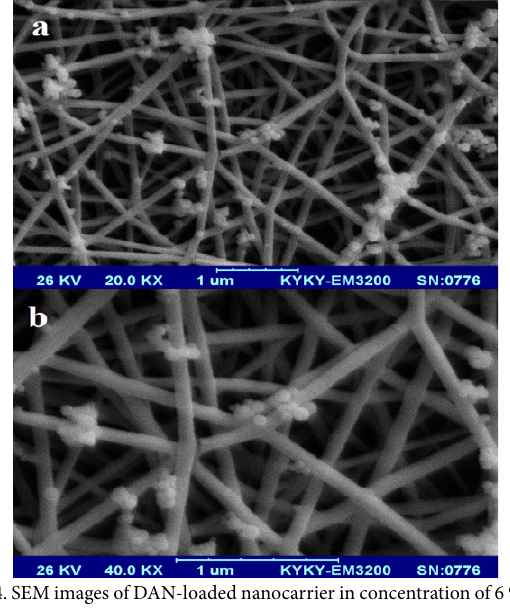
Fig. 3. Magnetic hysteresis curves of a) Fe Fig. 3 Magnetic hysteresis curves of a) Fe 3 O 4 and b) Fe 3 O 4 @SiO 2 nanostructures